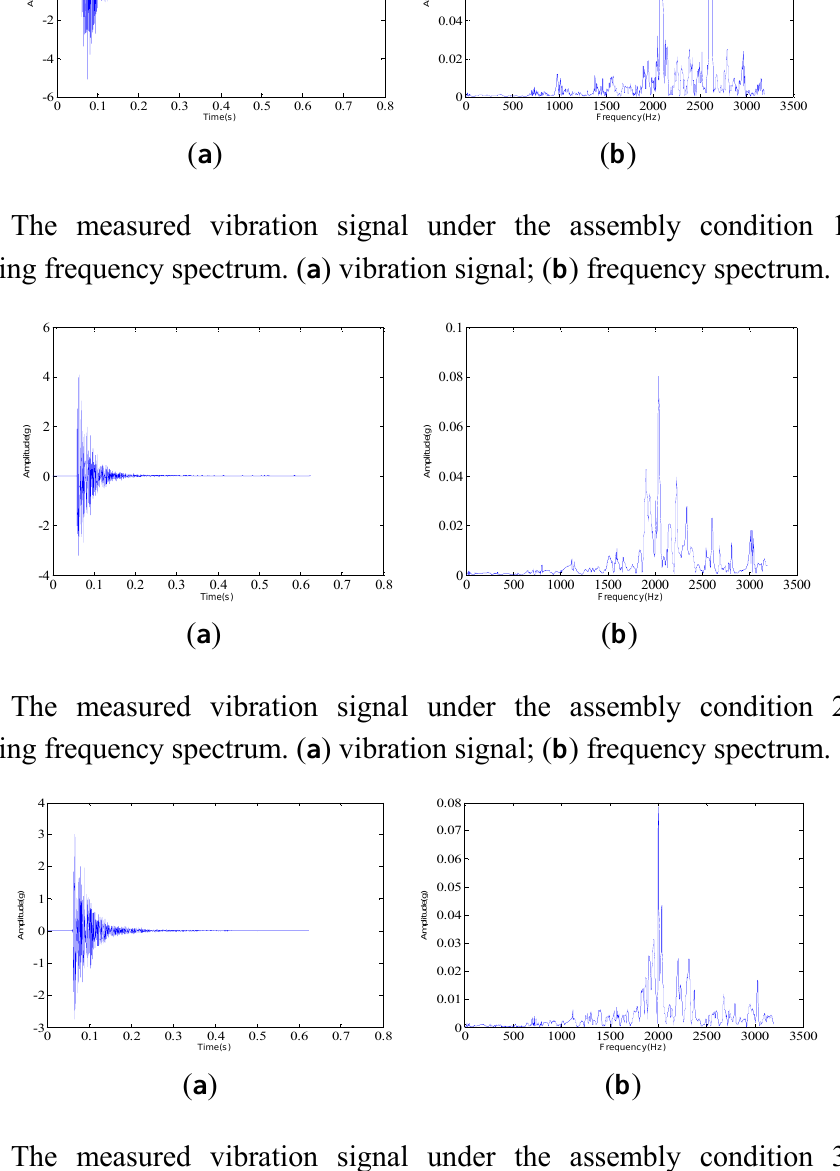
Figure 9. The measured vibration signal under the assembly condition 3 and the corresponding frequency spectrum. ( a ) vibration signal; ( b ) frequency